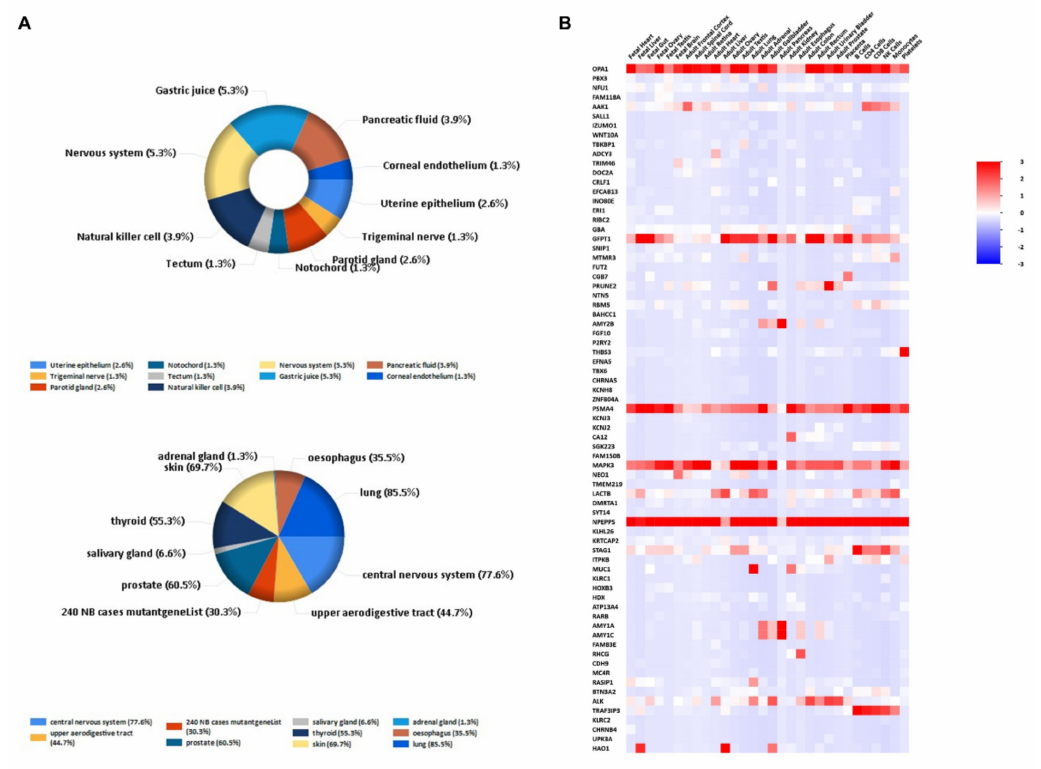
Figure 4. Dental-caries- and periodontitis-related gene expression distribution: ( A ) gene expression in human tissues and systems; ( B ) heatmap of each gene expression